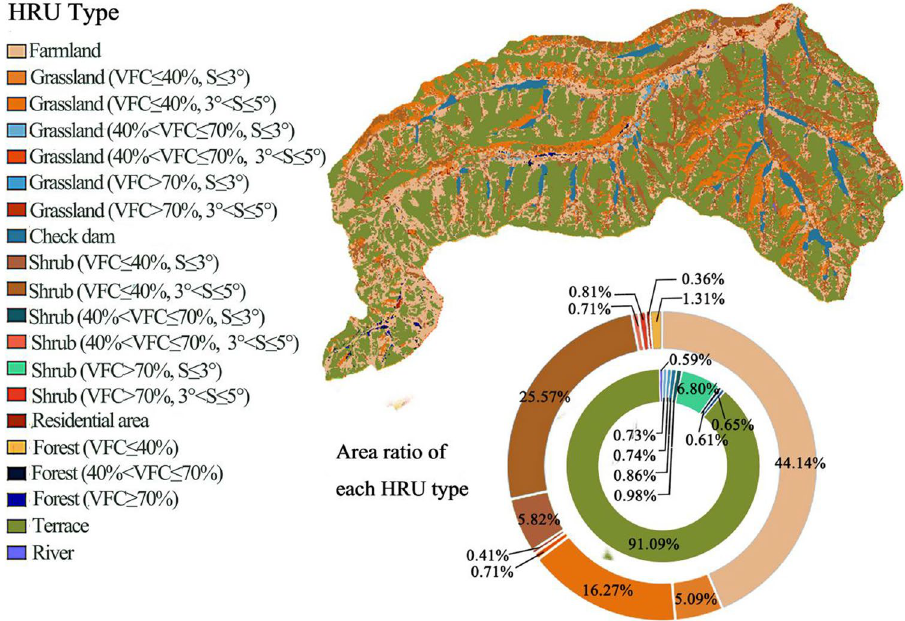
Fig. 8 Spatial distribution of each type of